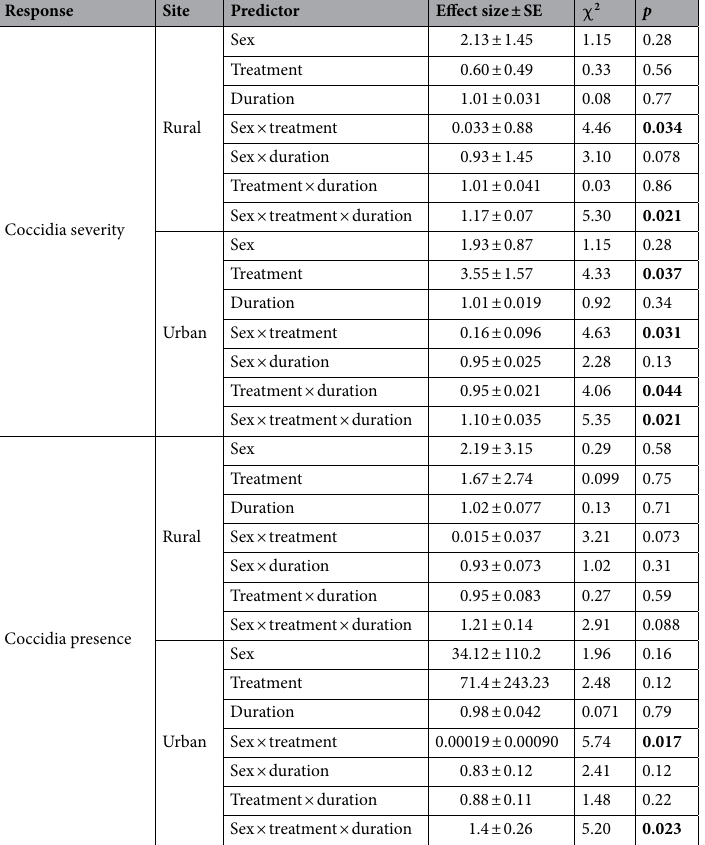
Table 1. Output of generalized linear models testing effects of sex, feeder treatment, time, and their interactions on coccidia severity and presence in birds from our rural (n = 75 males, 40 females) and urban (n = 62 males, 55 females) study sites. We used a quasipoisson error term in models of coccidia severity and a binomial error term in models of coccidia presence. Effect sizes are incident rate ratios for the coccidia severity models, and odds ratios for the coccidia presence models. Degrees of freedom in all tests = 1. Boldfaced p -values indicate significance at α =